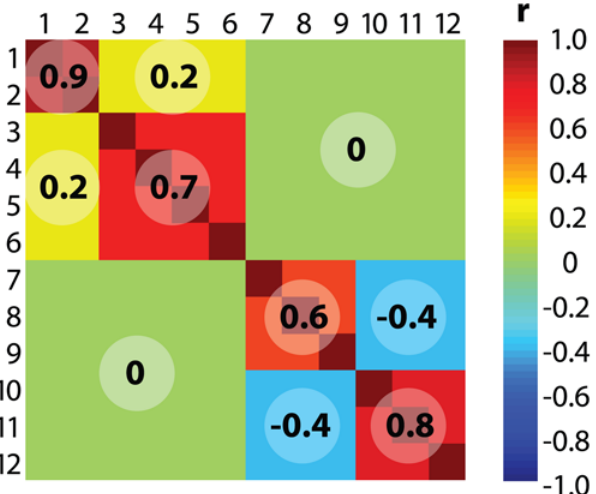
Figure 2. Correlation structure for simulated data. Twelve variables are correlated as shown in the figure. The heat map used to illustrate the pairwise correlations ranges from dark red (perfect correlation, r ~ 1 ) through green (no correlation, r ~ 0 ) to dark blue (perfect anticorrelation, r ~{ 1 ). On the diagonal are four correlated clusters of varying strength: {1,2} with an r of 0.9, {3,4,5,6} with an r of 0.7, {7,8,9} with an r of 0.6, and {10,11,12} with an r of 0.8. There are nonzero correlations between two pairs of clusters; members of {1,2} and {3,4,5,6} are positively correlated ( r ~ 0 : 2 ), while members of {7,8,9} and {10,11,12} are negatively correlated ( r ~{ 0 : 4 ).